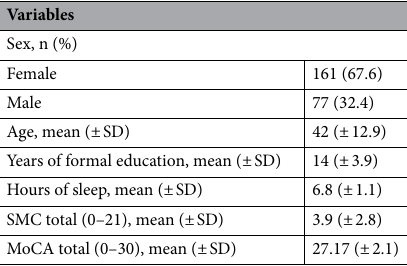
Table 1. Sample characteristics (n = 238).